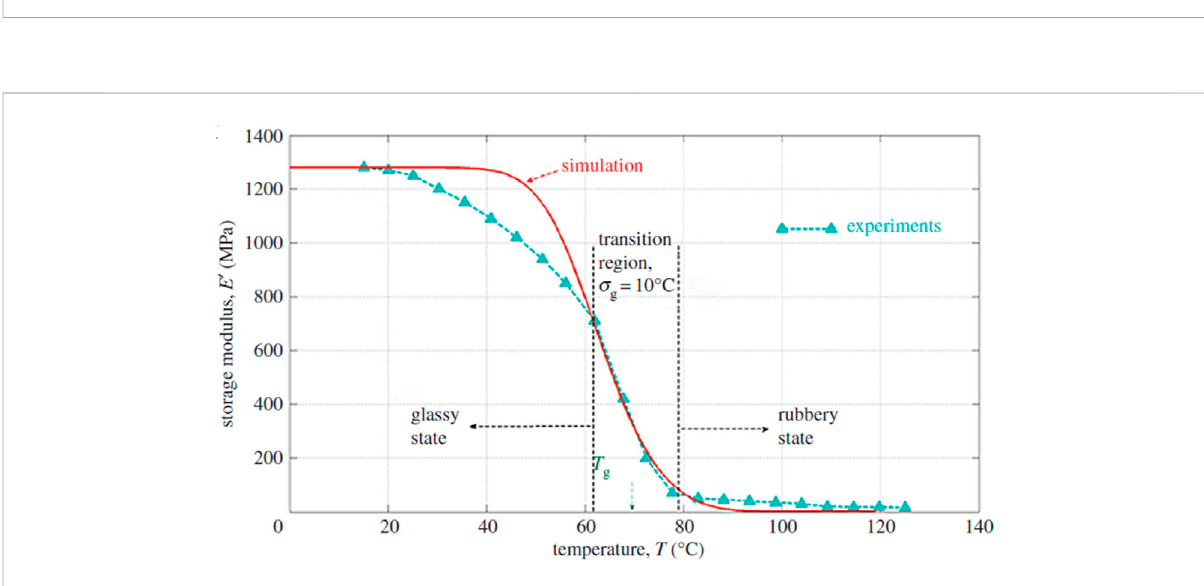
FIGURE 13 Experimentalandsimulationresultsforthestoragetensilemodulus,E,withstoragemodulus E 0 ′ =1,290 MPa(ShojaeiandLi,2014).[Reproduced with permission from Proceedings of the Royal Society A, 470: 20140199., (2014). Copyright 2014 Royal